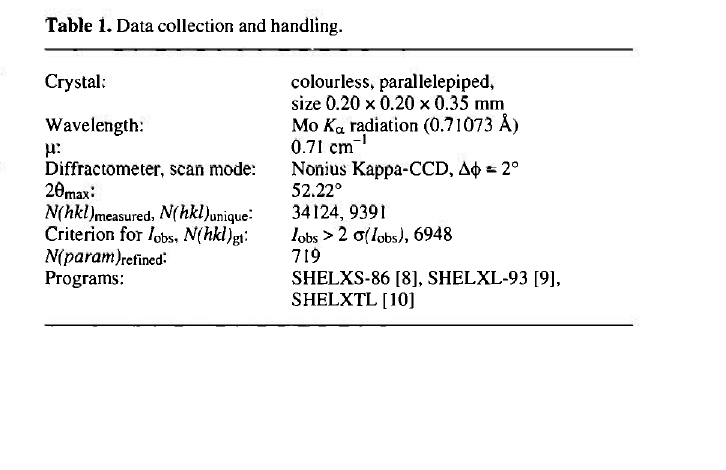
Table 1. Data collection and handling.